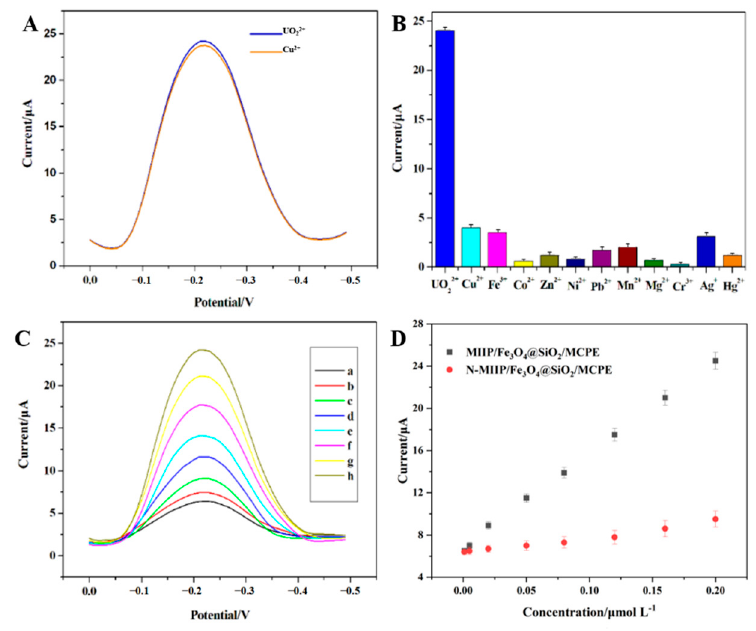
Figure 6. ( A ) The DPV signal of sensor after reaction in solution containing different metal ions; ( B ) when the Cu 2+ /UO 22+ ratio is 125:1, the influence of the presence of copper on the volt-ammetry signal of uranyl ions; ( C ) the MIIP/Fe 3 O 4 @SiO 2 /MCPE in different concentrations of UO 22+ (a: 0.001 μ mol L − 1 ; b: 0.005 μ mol L − 1 ; c: 0.02 μ mol L − 1 ; d: 0.05 μ mol L − 1 ; e: 0.08 μ mol L − 1 ; f: 0.12 μ mol L − 1 ; g: 0.16 µ mol L − 1 ; h: 0.2 μ mol L − 1 ) and ( D ) show the calibration curves of MIIP/Fe 3 O 4 @SiO 2 /MCPE.